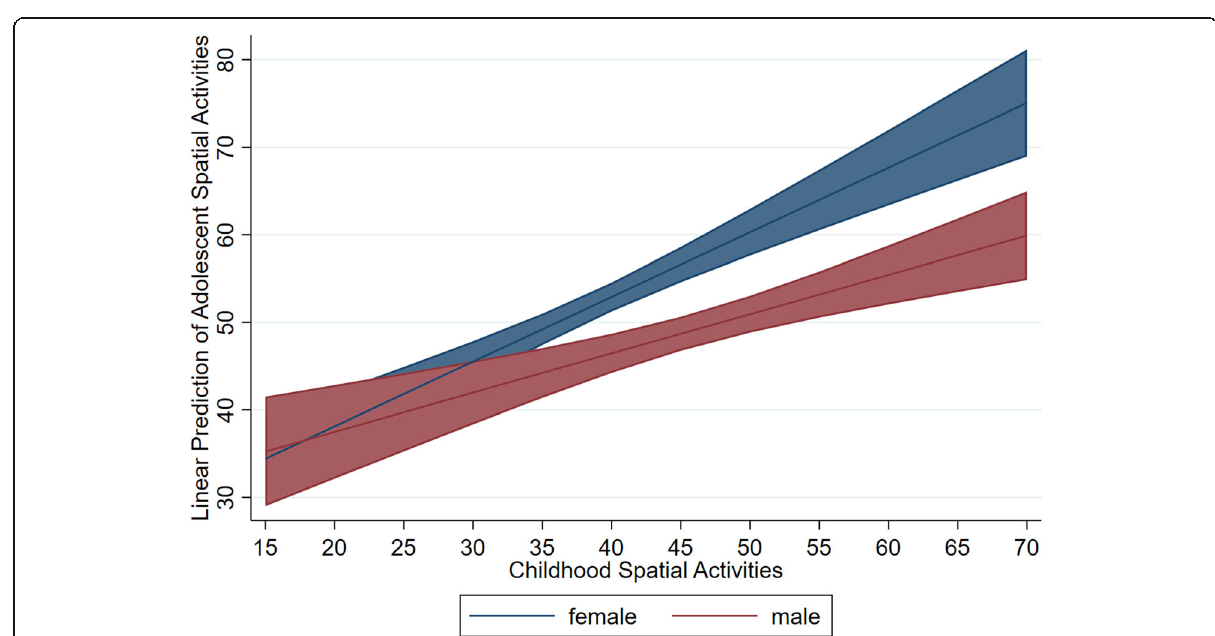
Fig. 2 Relation between Childhood Activities and Adolescent Activities by Gender. Predictive margins of gender with 95%